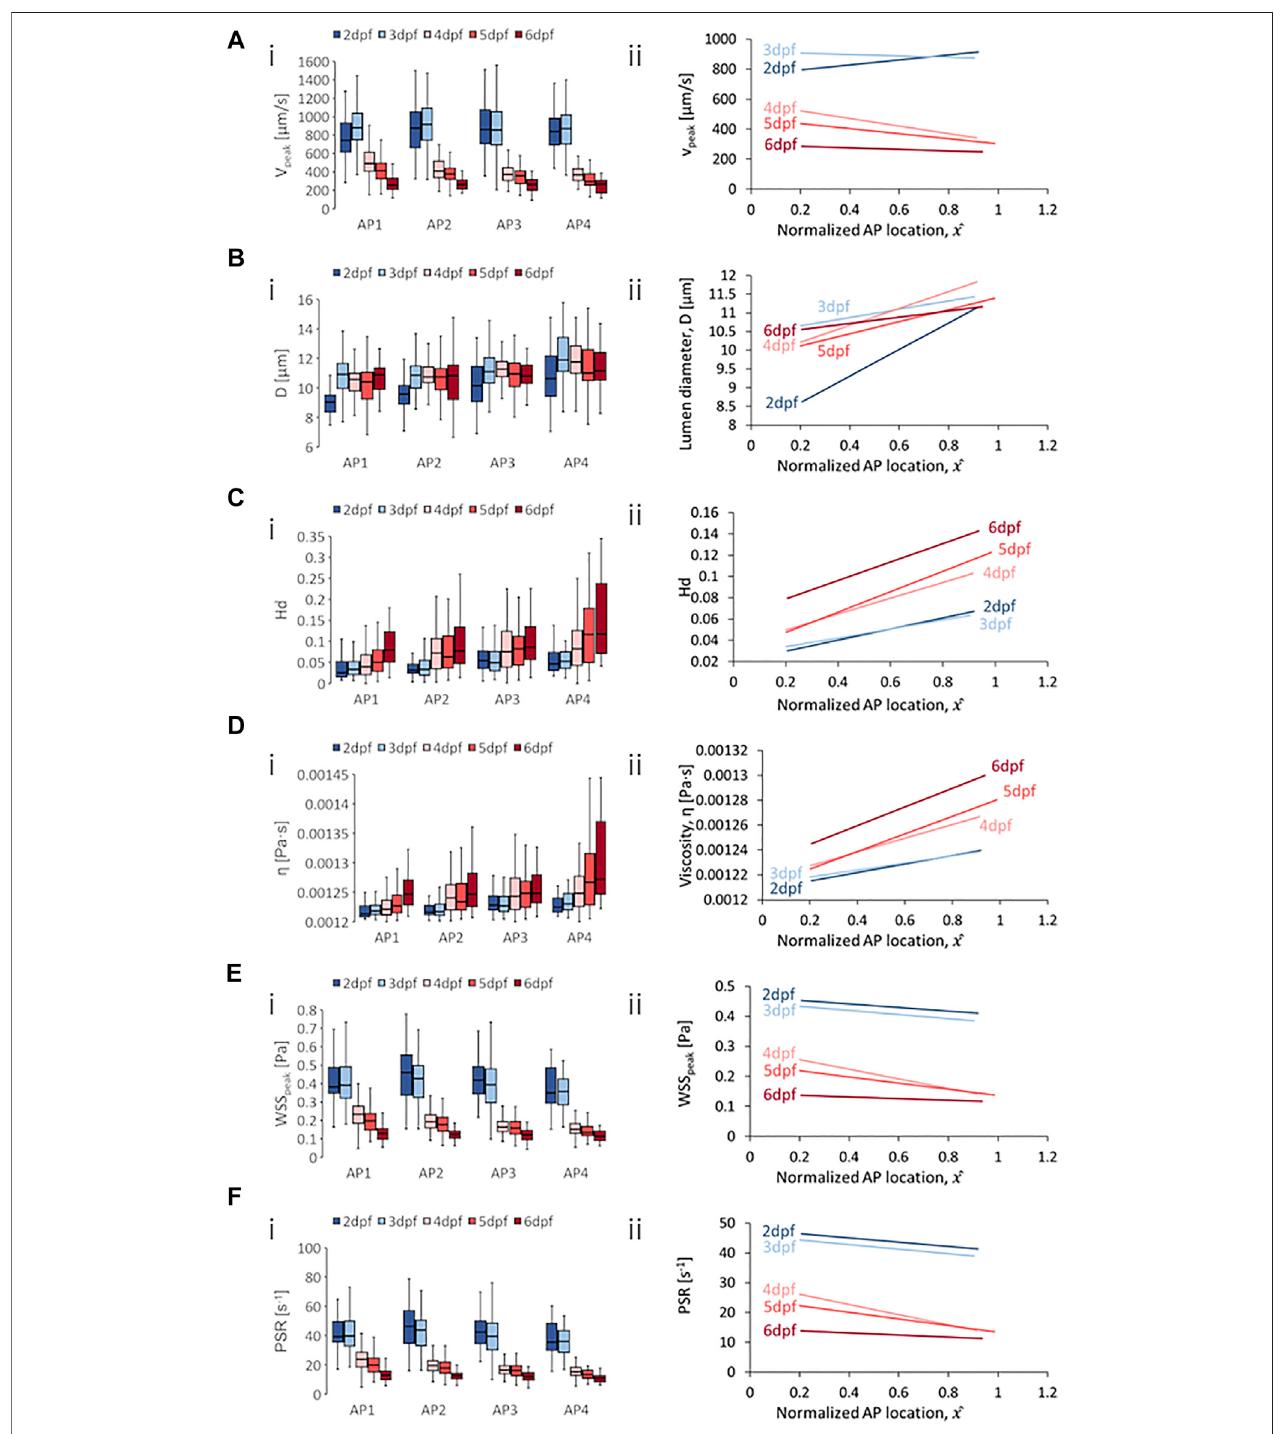
FIGURE 7 | Developmental trends of morphological and hemodynamic quantities in the venous intersegmental vessels (vISVs). (A) The changes in V peak at four regionsalongtheanterior-to-posterior(AP)axis (i) andtheAPtrendfor V peak (ii) . (B) Thechangesin D atfourAPregions (i) andtheAPtrendfor D (ii) . (C) Thechangesin H d atfourAPregions (i) andtheAPtrendfor H d (ii) . (D) Thechangesin η atfourAPregions (i) andtheAPtrendfor η (ii) . (E) Thechangesin WSS peak atfourAPregions (i) and the AP trend for WSS peak (ii) . (F) The changes in PSR at four AP regions (i) and the AP trend for PSR (ii) . Box plots in (i) of Panels (A – D) show the median and the fi rst (Q1) and third (Q3) quartile levels of the hemodynamic quantity for the pooled zebra fi sh data. The whisker bars represent the maximum and minimum ranges of the data that lie within 1.5 times of the interquartile range (IQR = Q3 − Q1) beyond Q1 and Q3.